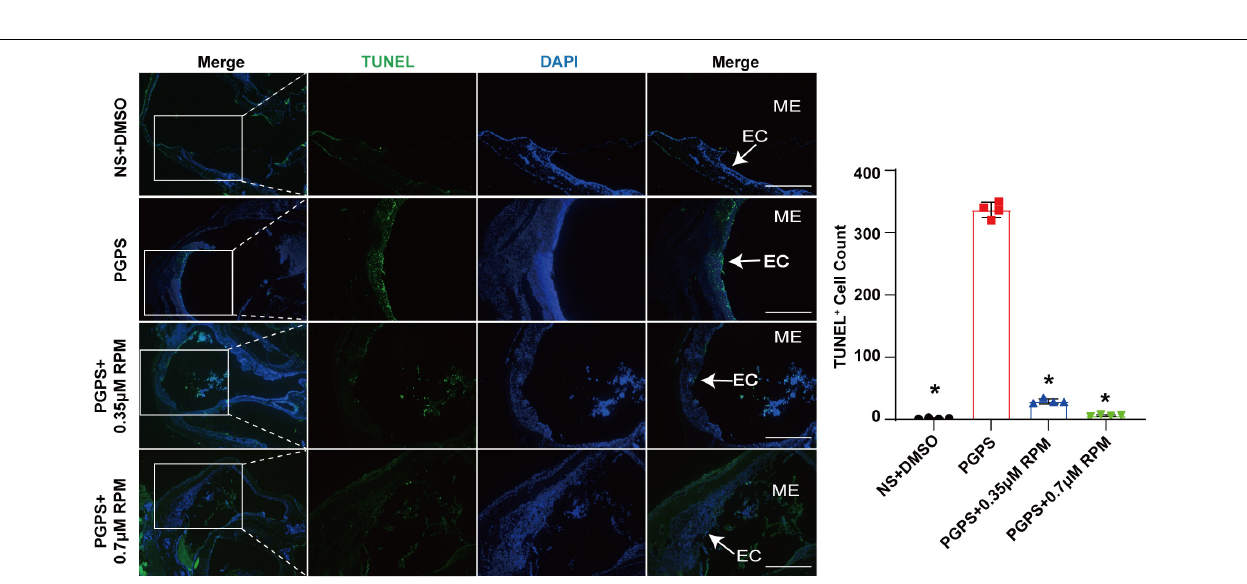
FIGURE 9 | Rapamycin treatment relieved ME epithelial cell apoptosis. Apoptotic cells in the MEs were examined by TUNEL staining. The quantitative image of apoptotic cells was shown in Figure B. The PGPS + 0.7 µ M RPM group showed fewer TUNEL-positive epithelial cells than the PGPS group. ME represents the middle ear; EC represents epithelial cells. * P < 0.05 vs. the PGPS group, n = 4 per group, Scale bar = 500 µ m, one-way ANOVA.